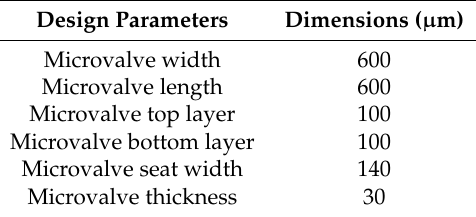
Figure 1. Normally closed (NC) microvalves: ( a ) 3D microvalve, and dimensions of top and bottom actuation chamber; ( a 1 ) Structural membrane; ( b , b 1 ) Cross-sectional view of microvalves open and closed structural domain in A-A’ position, and source, drain and gate regions of the valve. Open and closed states of microvalve: ( c , c 1 ) top view of microvalve, and measurement of different vertex positions. Table 1. Dimensions of